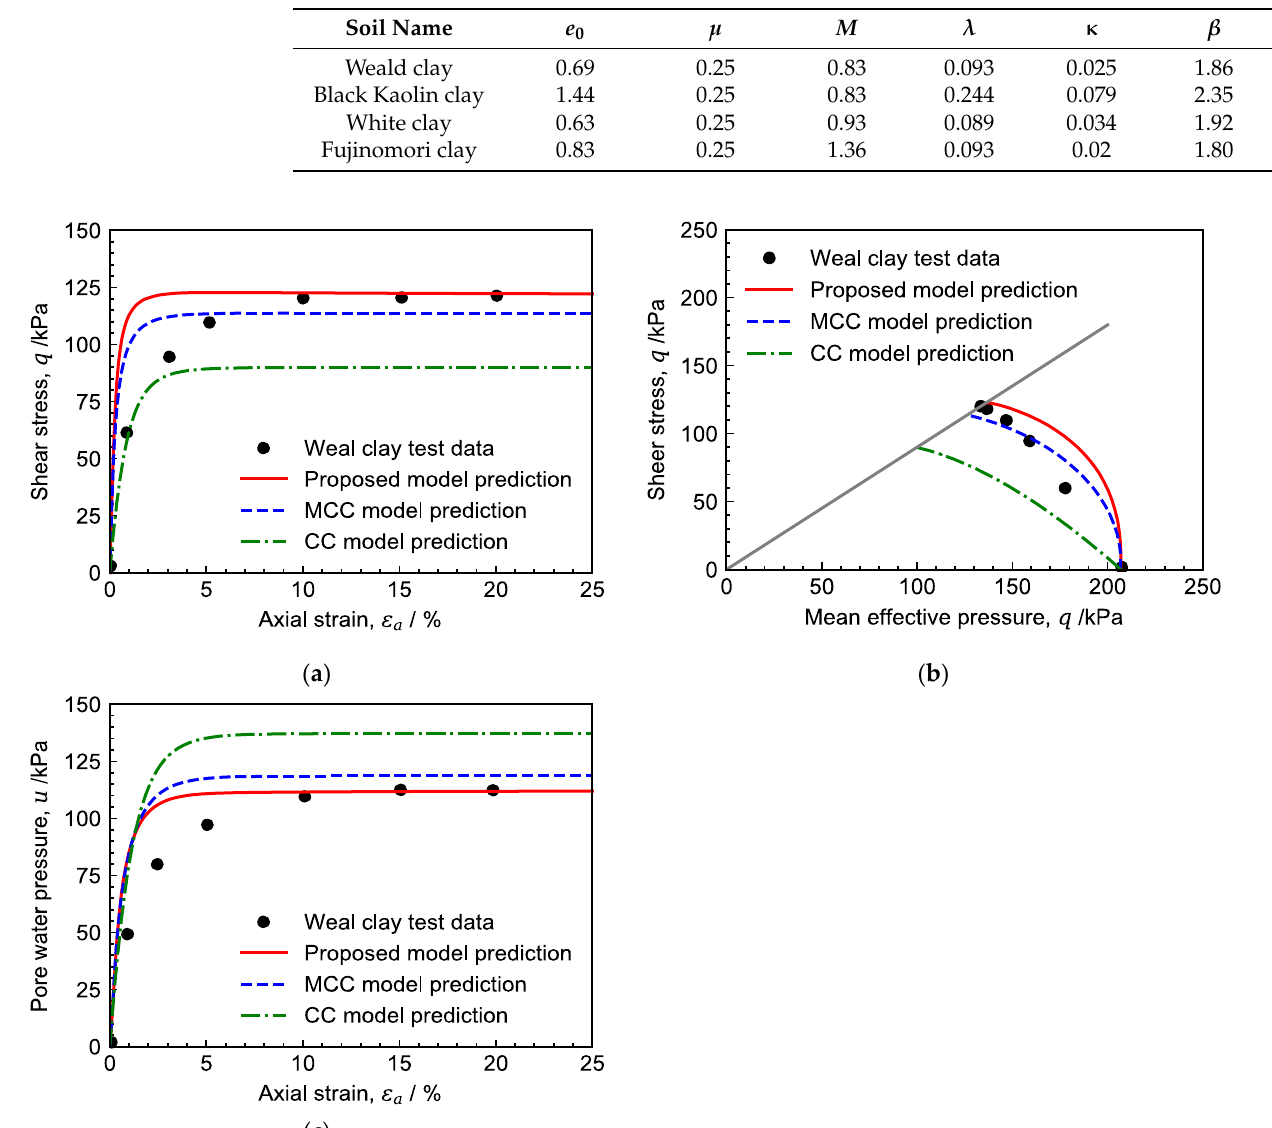
Table 1. Model parameters of the clays.